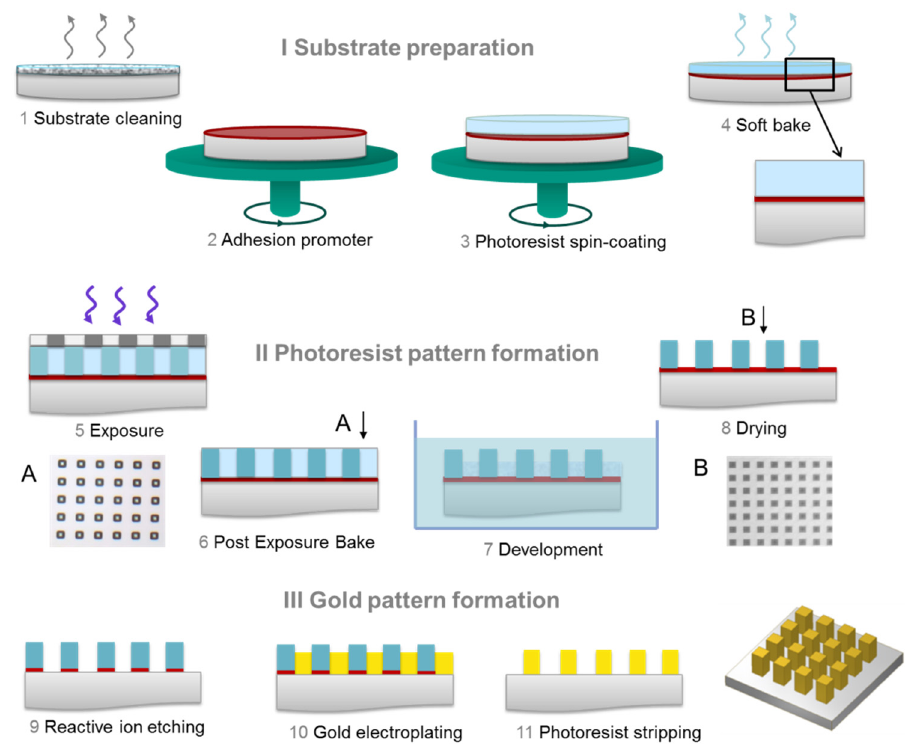
Figure 2. Fabrication process steps of UV LIGA: substrate preparation consisting of cleaning of the surface and applying the photoresist; photoresist pattern formation with exposure and development; and gold pattern formation by electroplating and stripping of the photoresist.